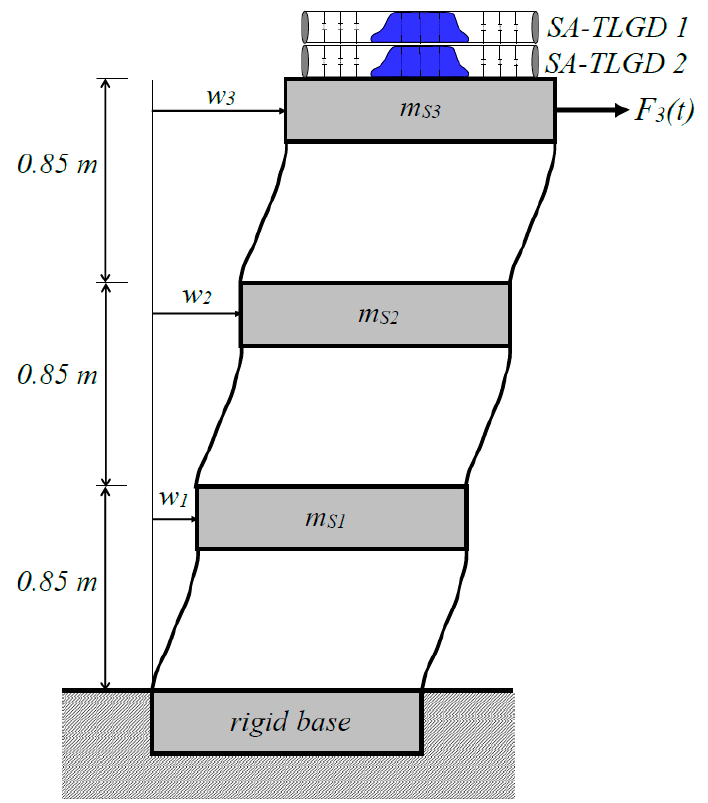
Figure 8. Scaled three-DOF-shear frame structure under horizontal force excitation F 3 ( t ) with two SA-TLGDs in parallel connection attached to the 3rd floor.